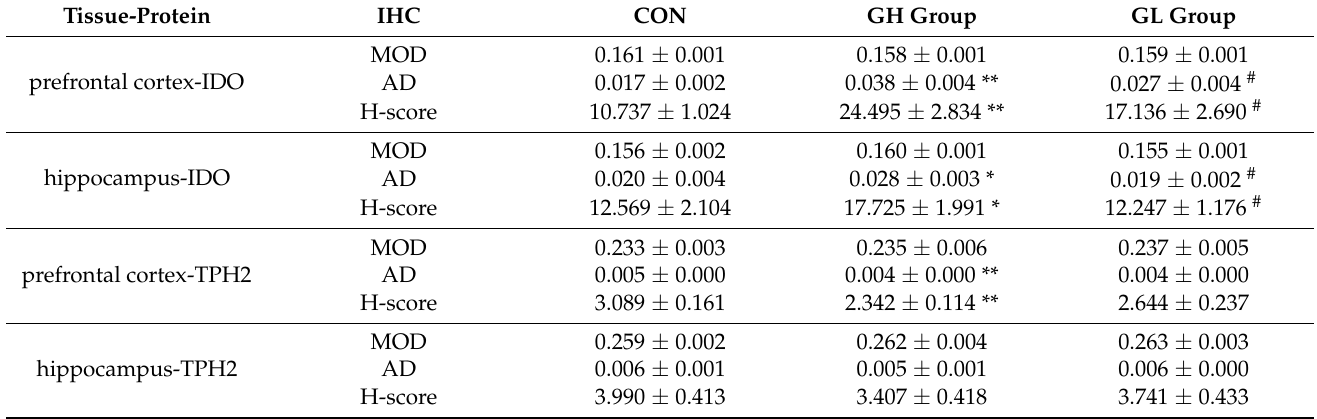
Table 1. Comparison of IDO and TPH2 immuno-positive MOD, AD and H-score in different brain regions of rats in each group.